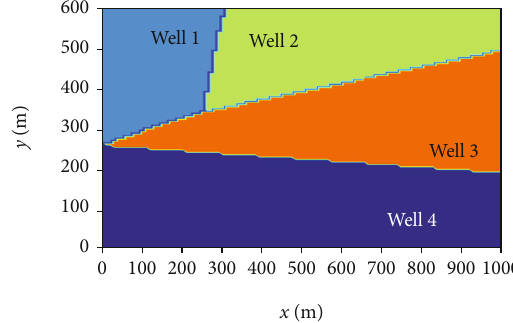
Figure 5: Geometries of the control volumes of the four fractured wells of model